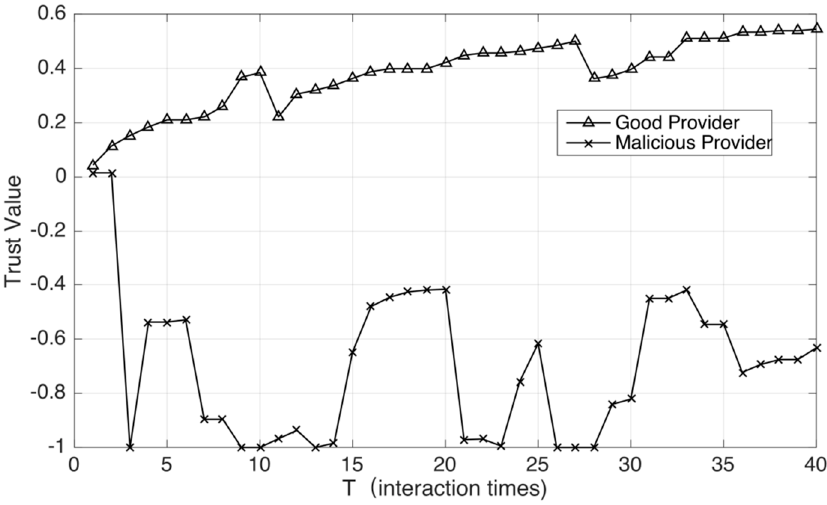
Figure 5. Trust evaluation of opportunistic service providers and benign service providers.